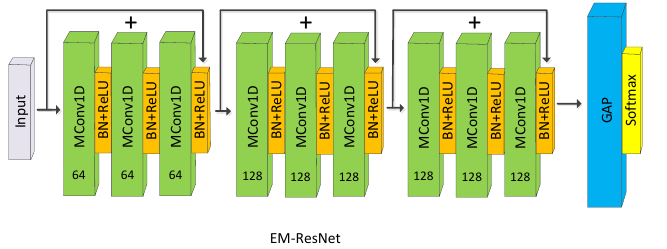
Figure 4. Architecture of EM-ResNet, MConv1D denotes the one-dimensional MConv layer. Compared with the EM-FCN and EM-ResNet, EM-Inception (Figure 5) is based on Inception [24] which extracts features in a multiscale manner. Inception is composed of two bottlenecks, one GAP layer, and one FC layer.